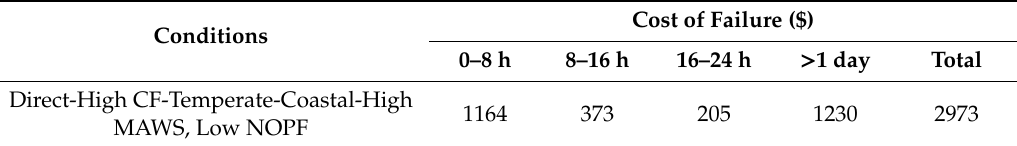
Table 5. Summary of cost of failures for every time-to-repair class.